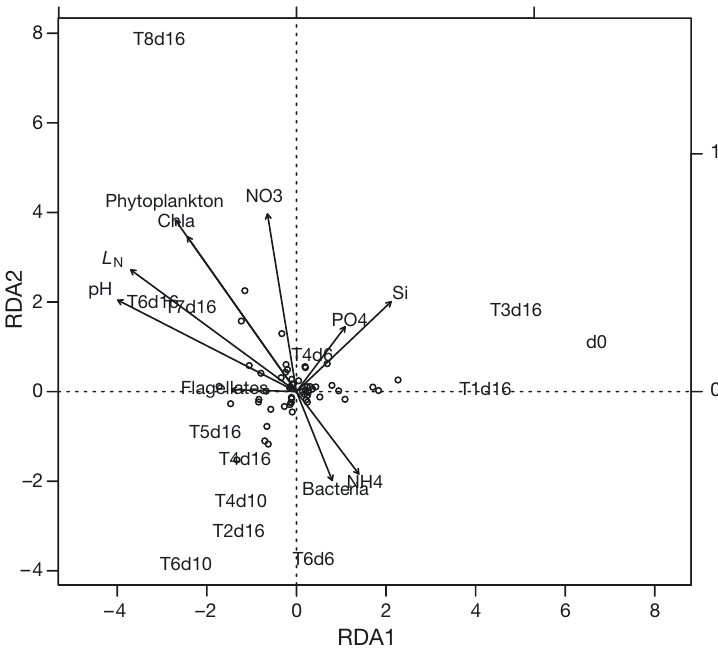
Fig. 5. Redundancy analysis (RDA) plot based on the square root-transformed DGGE band intensity matrix and standardized environmental variables (NH 4 : ammonium, NO 3 : nitrate, Si: silicon, L N : ammonium-loading rate, chl a : chloro- phyll a and abundance of bacteria, flagellates and phytoplankton) from all sam- ples from the microcosm experiment. The environmental variables are shown as vectors. The samples are represented by treatment number (T1−8, see Table 1) and day number (d); d0 is the Day 0 sample. Small circles indicate DGGE bands representing bacterial species. Of the variance, 89% was constrained by the components (axes), i.e. environmental variables. The proportion of the total vari- ance explained by the first 2 axes was 41%, and of the constrained part of the variance, the first 2 axes covered 46%. The permutation test for RDA indicated significance of the constraints on microbial community structure when all con- straints (environmental variables) were included (p = 0.036). When testing for in- dividual environmental variables as constraints, ammonium-loading rate ( L N ), pH, chlorophyll a (chl a ) and phytoplankton abundance were significant (p < 0.05)